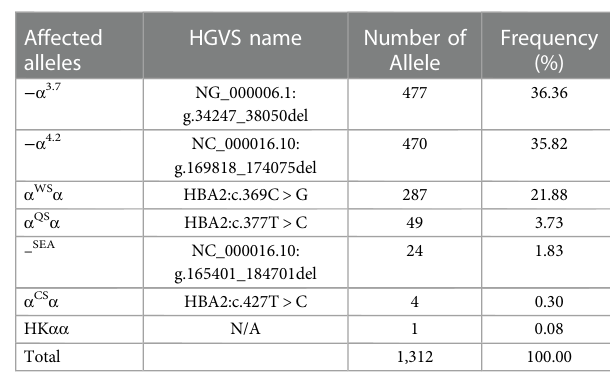
HGVS, human genome variation society.